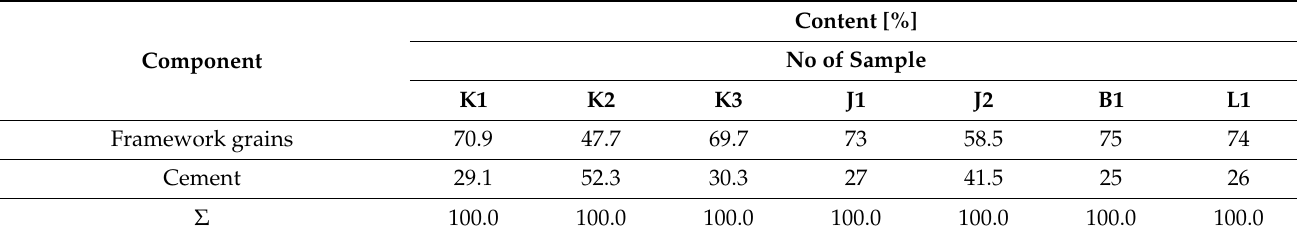
Table 2. Participation of framework grains and cement in